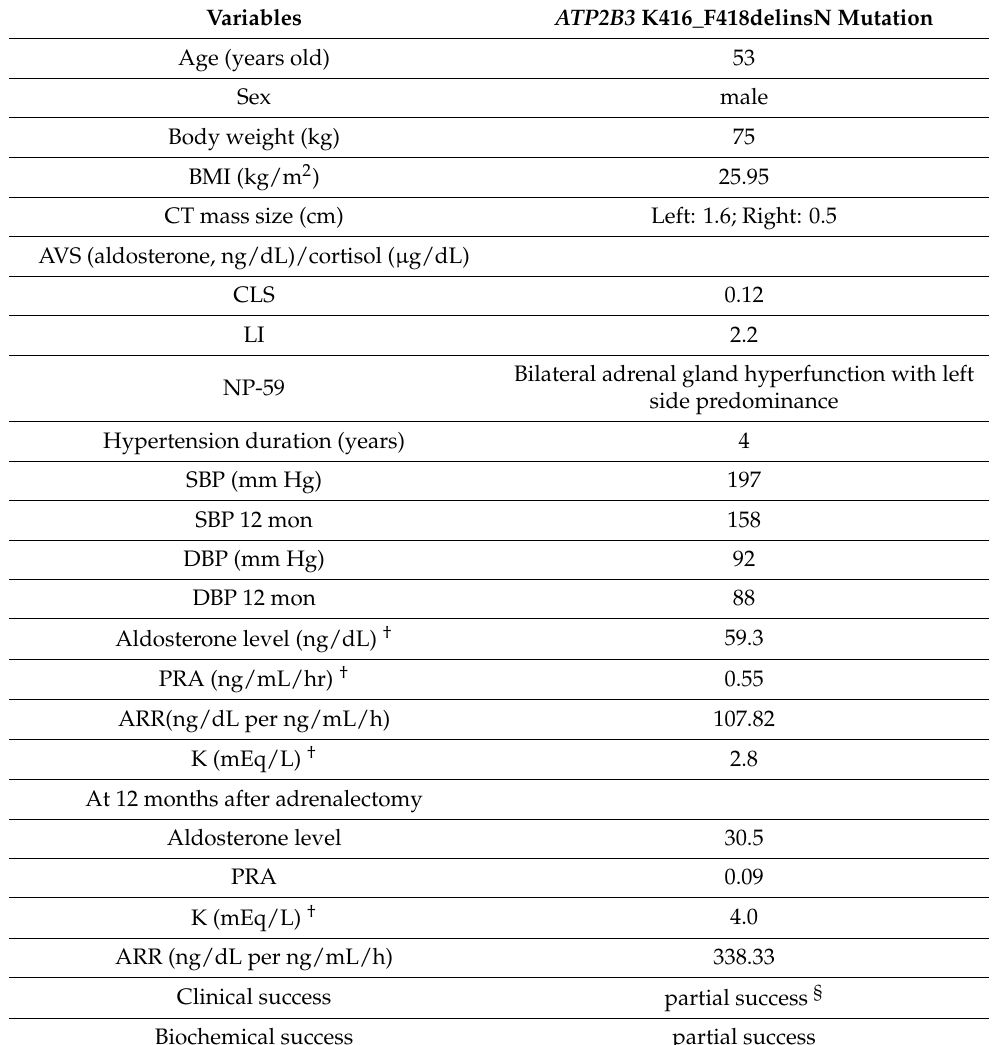
Table 1. The basal characteristics of the uPA patient with adenoma harboring ATP2B3 K416- F418delinsN deletion